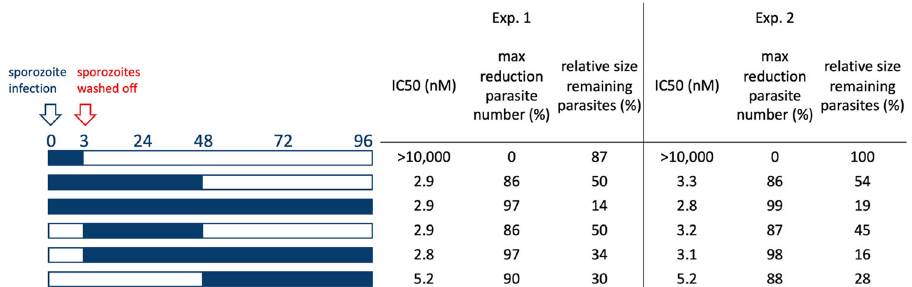
Fig. 4 Mode of action of P218 on sporozoite hepatocyte invasion and schizont maturation. Plasmodium falciparum NF175 sporozoites/infected HC10-10 hepatocytes were incubated with serial dilutions according to the scheme indicated on the left of the fi gure. Blue bars indicate the presence of the compound, with daily refreshments for longer incubations. The table indicates IC50 values determined in two independent experiments, with two replicates per experiment. In addition, the table lists the maximum reduction in parasite numbers that were achieved (plateau of the dose-response curve), and the relative sizes of remaining parasites in comparison with vehicle controls (0.1% DMSO).